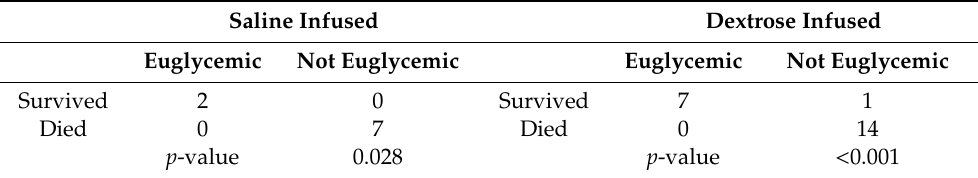
Table 1. Euglycemia is associated with survival in a murine KP model.